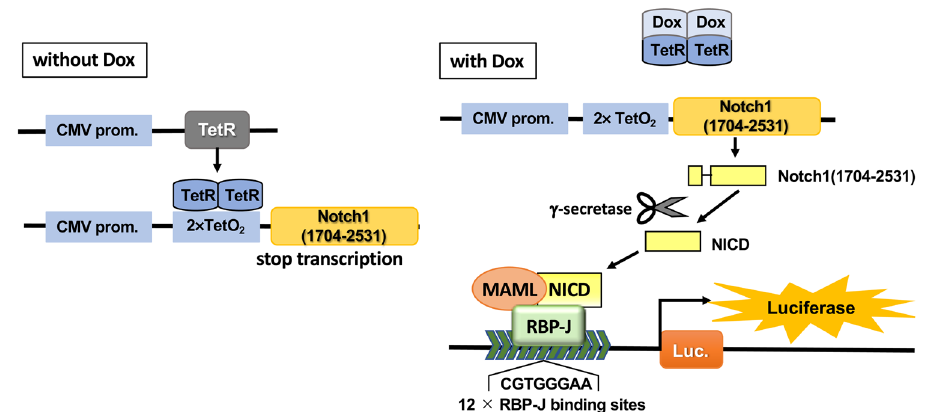
Figure 2. The T-REx assay system. Without Dox, expression of Notch1(1704–2531) is suppressed by TetR. The addition of Dox inactivates TetR to initiate expression of Notch1(1704–2531), which is then cleaved by endogenous γ -secretase to form NICD. NICD then translocates to the nucleus and forms a heterotrimer with RBP-J and MAML that binds to a 12 × RBP-J binding site to drive luciferase expression. Luciferase activity was detected as Notch signaling pathway activity. Dox: doxycycline, TetR: tetracycline repressor, Luc.: